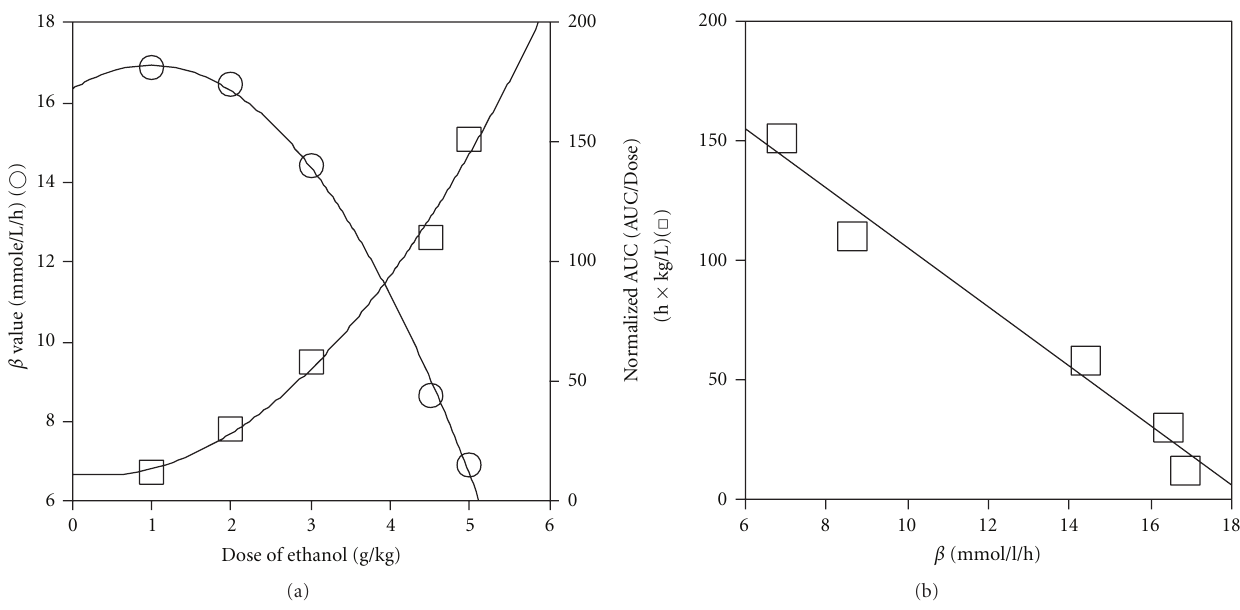
Figure 2: (a) E ff ect of ethanol dose on elimination rate ( β ) and normalized AUC (AUC/dose) of blood ethanol. (b) Correlation of normalized AUC with β in mice for various doses of ethanol. β ( (cid:2) ) and normalized AUC ( (cid:2) ) were calculated from the regression line fitted to the blood ethanol concentrations at each dose in Figure 1.